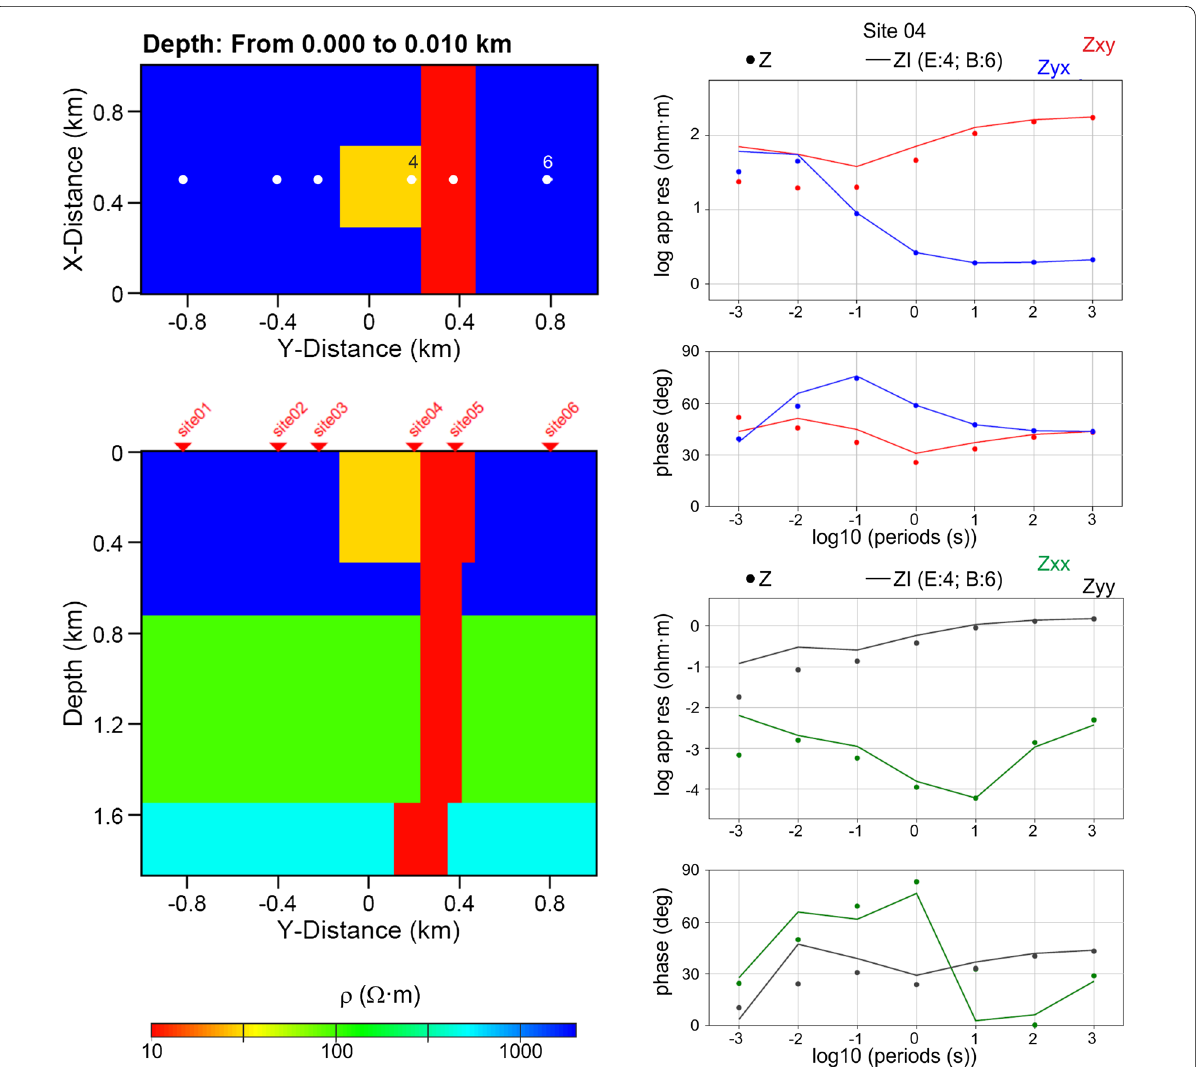
Fig. 4 Left: plan view at the surface (top) and cross section beneath the profile (bottom) for synthetic Model 2. Right: responses calculated at Site 4 from Z (dots) and ZI (lines): xy and yx components (top) and xx and yy components